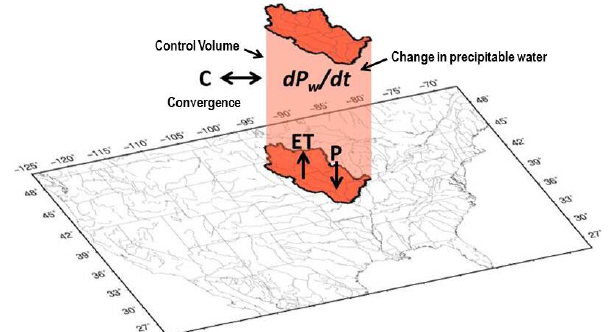
Fig. 2. Small-scale study domain comprised of 250 tributary catch- ments using USGS stream gauges that were screened to be mini- mally affected by diversions, with at least 20yr of data in the past 3 decades to facilitate multi-criteria comparisons.